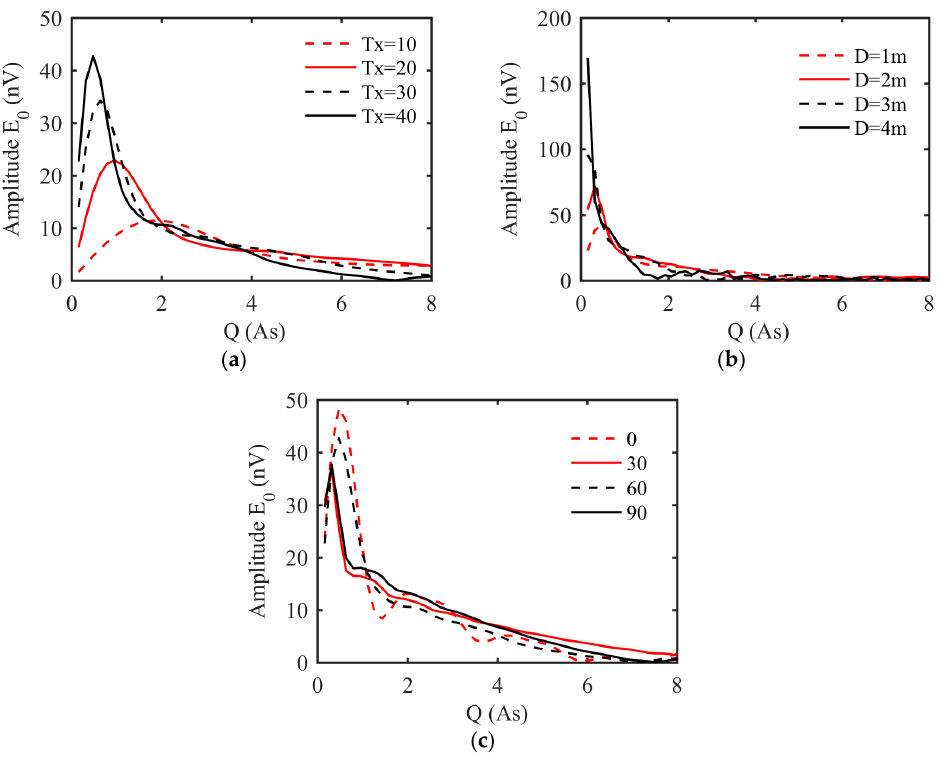
E q − curves from the forward model for a 2-m-thick Figure 4. The underground MRS response 0 Figure 4. The underground MRS response E 0 − q curves from the forward model for a 2-m-thick water-bearing structure located 10 m ahead of the tunnel face with a water content of 100% ( a ) results water-bearing structure located 10 m ahead of the tunnel face with a water content of 100% ( a ) results assuming a 1-m-diameter coil; 128 turns for Rx; 10, 20, 30, or 40 turns for Tx; geomagnetic inclination assuming a 1-m-diameter coil; 128 turns for Rx; 10, 20, 30, or 40 turns for Tx; geomagnetic inclination of 60°; and geomagnetic declination of 0°; ( b ) results assuming 40 turns for Tx; 128 turns for Rx; coil of 60 ◦ ; and geomagnetic declination of 0 ◦ ; ( b ) results assuming 40 turns for Tx; 128 turns for Rx; coil diameter of 1, 2, 3, or 4 m; geomagnetic inclination of 60°; and geomagnetic declination of 0°; ( c ) results diameter of 1, 2, 3, or 4 m; geomagnetic inclination of 60 ◦ ; and geomagnetic declination of 0 ◦ ; ( c ) results assuming a 1-m-diameter coil, 40 turns for Tx, 128 turns for Rx, and geomagnetic inclination of 0, 60, assuming a 1-m-diameter coil, 40 turns for Tx, 128 turns for Rx, and geomagnetic inclination of 0, 60, or 90°. or 90 ◦ E q − curves that were generated using a model of a 2-m-thick water- Figure 4b shows the 0 bearing structure located 10 m ahead of the tunnel face with a water content of 100% and a coil diameter of 1, 2, 3, or 4 m. As shown in the figure, as the coil diameter gradually increases, the maximum initial amplitude of the signal becomes larger and moves to the left in the direction in which the value decreases. Thus, as the diameter of the coil sensor increases, the excitation pulse needed to detect a water-bearing structure at a certain depth can be decreased accordingly. E q − curves that were generated using a model for a 2-m-thick water- Figure 4c shows the 0 bearing structure located 10 m ahead of the tunnel face with a water content of 100% and a geomagnetic inclination of 0°, 60°, or 90°. The curves clearly change with varying inclination, and the